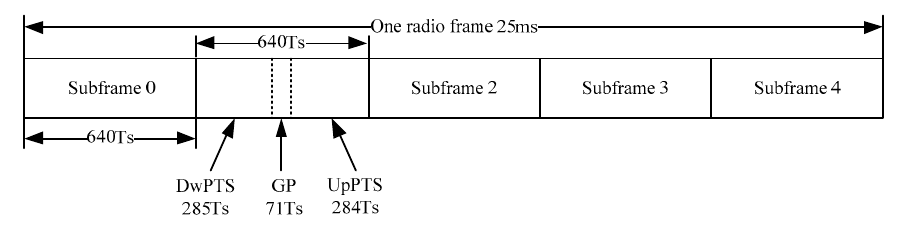
Figure 7. Frame structure of LTE 230.